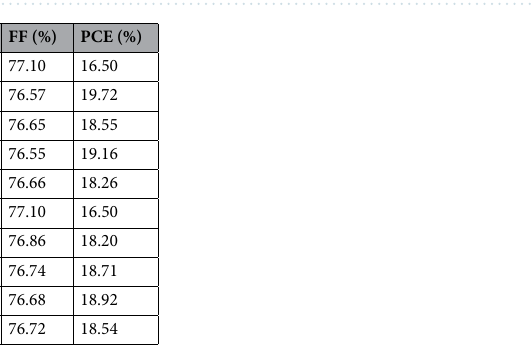
Table 1. Electrical characteristics of the simulated devices incorporated with SiO 2 @Ag@SiO 2 and Ag@SiO 2 NPs with different mass ratios.